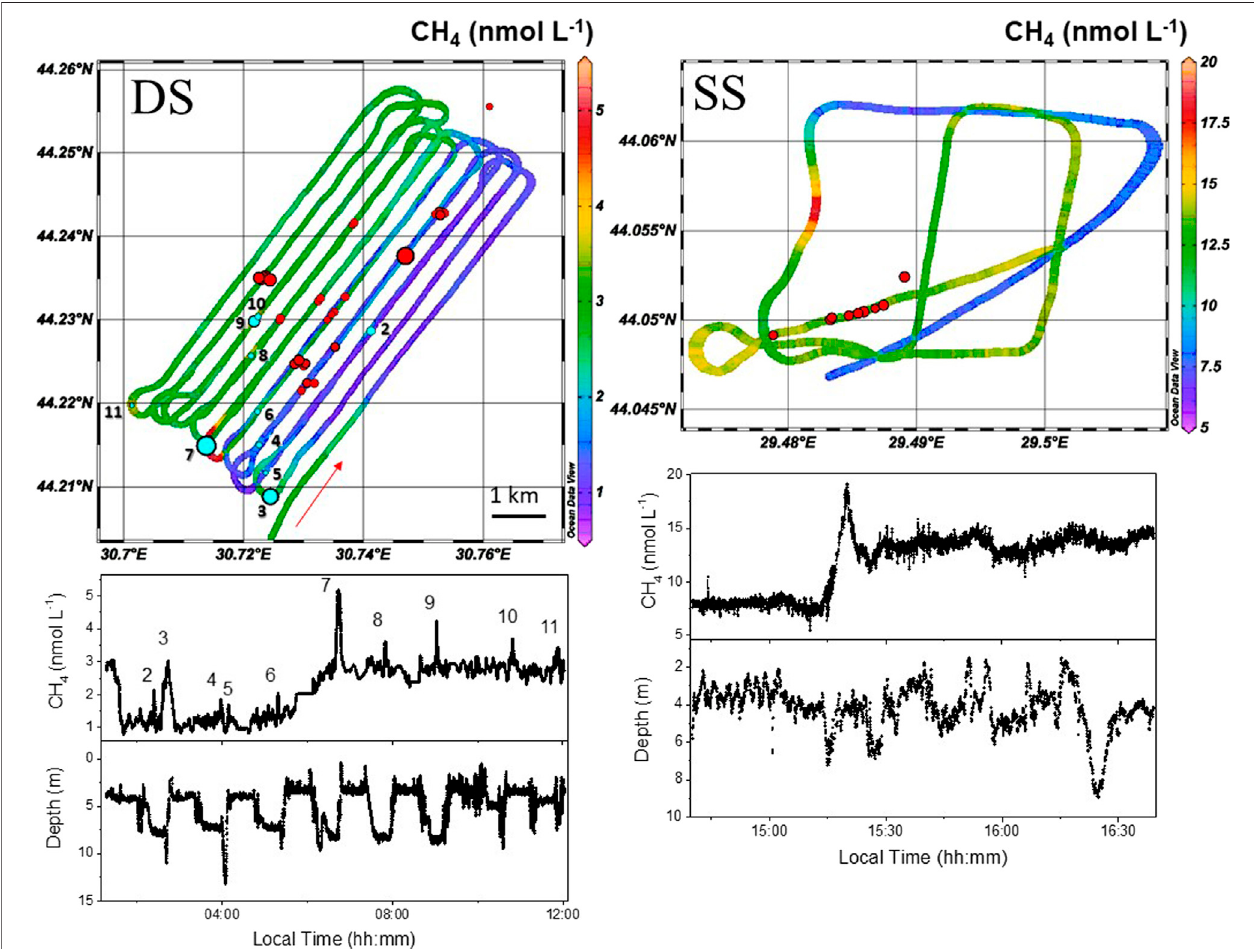
FIGURE 4 | 2D surface dissolved methane distribution (color map) at the deeper (DS, left) and shallower (SS, right) site. Both surveys were conducted near surface.Thethicknessofthecolormap( ∼ 60 m)waschosenaccordinglytothe2 σ accuracyoftheGPSpositioning.Redarrowsindicatethetimedirection.Redandlight- blue dotsshow thelocationsofthe fl ares(echosounder)and surfacedissolved CH 4 (MILS)peaks, respectively,both withthesizeproportionaltotheestimated intensity. Peak 1 is only visible in Figure 6 , because itis located at a southern position with respect to the performed grid. At the bottom, the time series of the data together with the water depth information. Localized peaks of dissolved CH 4 were observed at certain locations, which seems uncorrelated with the fl are locations.